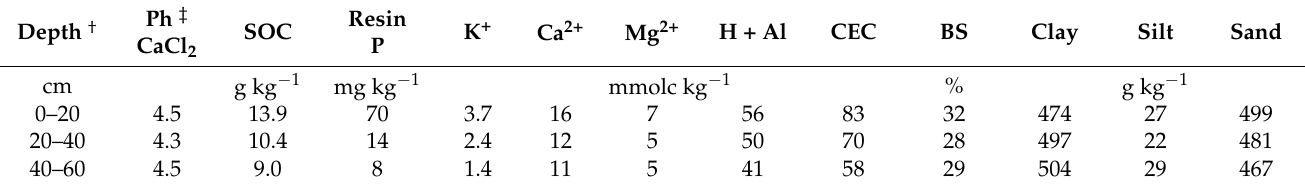
Table 1. Soil chemical attributes and granulometry of experimental area before the experiment combining cover crops and nitrogen